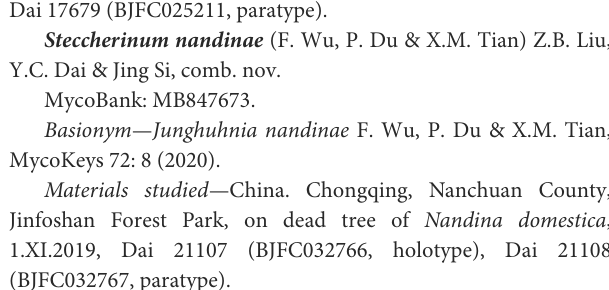
(BJFC025072, holotype); Hainan Province, Wuzhishan